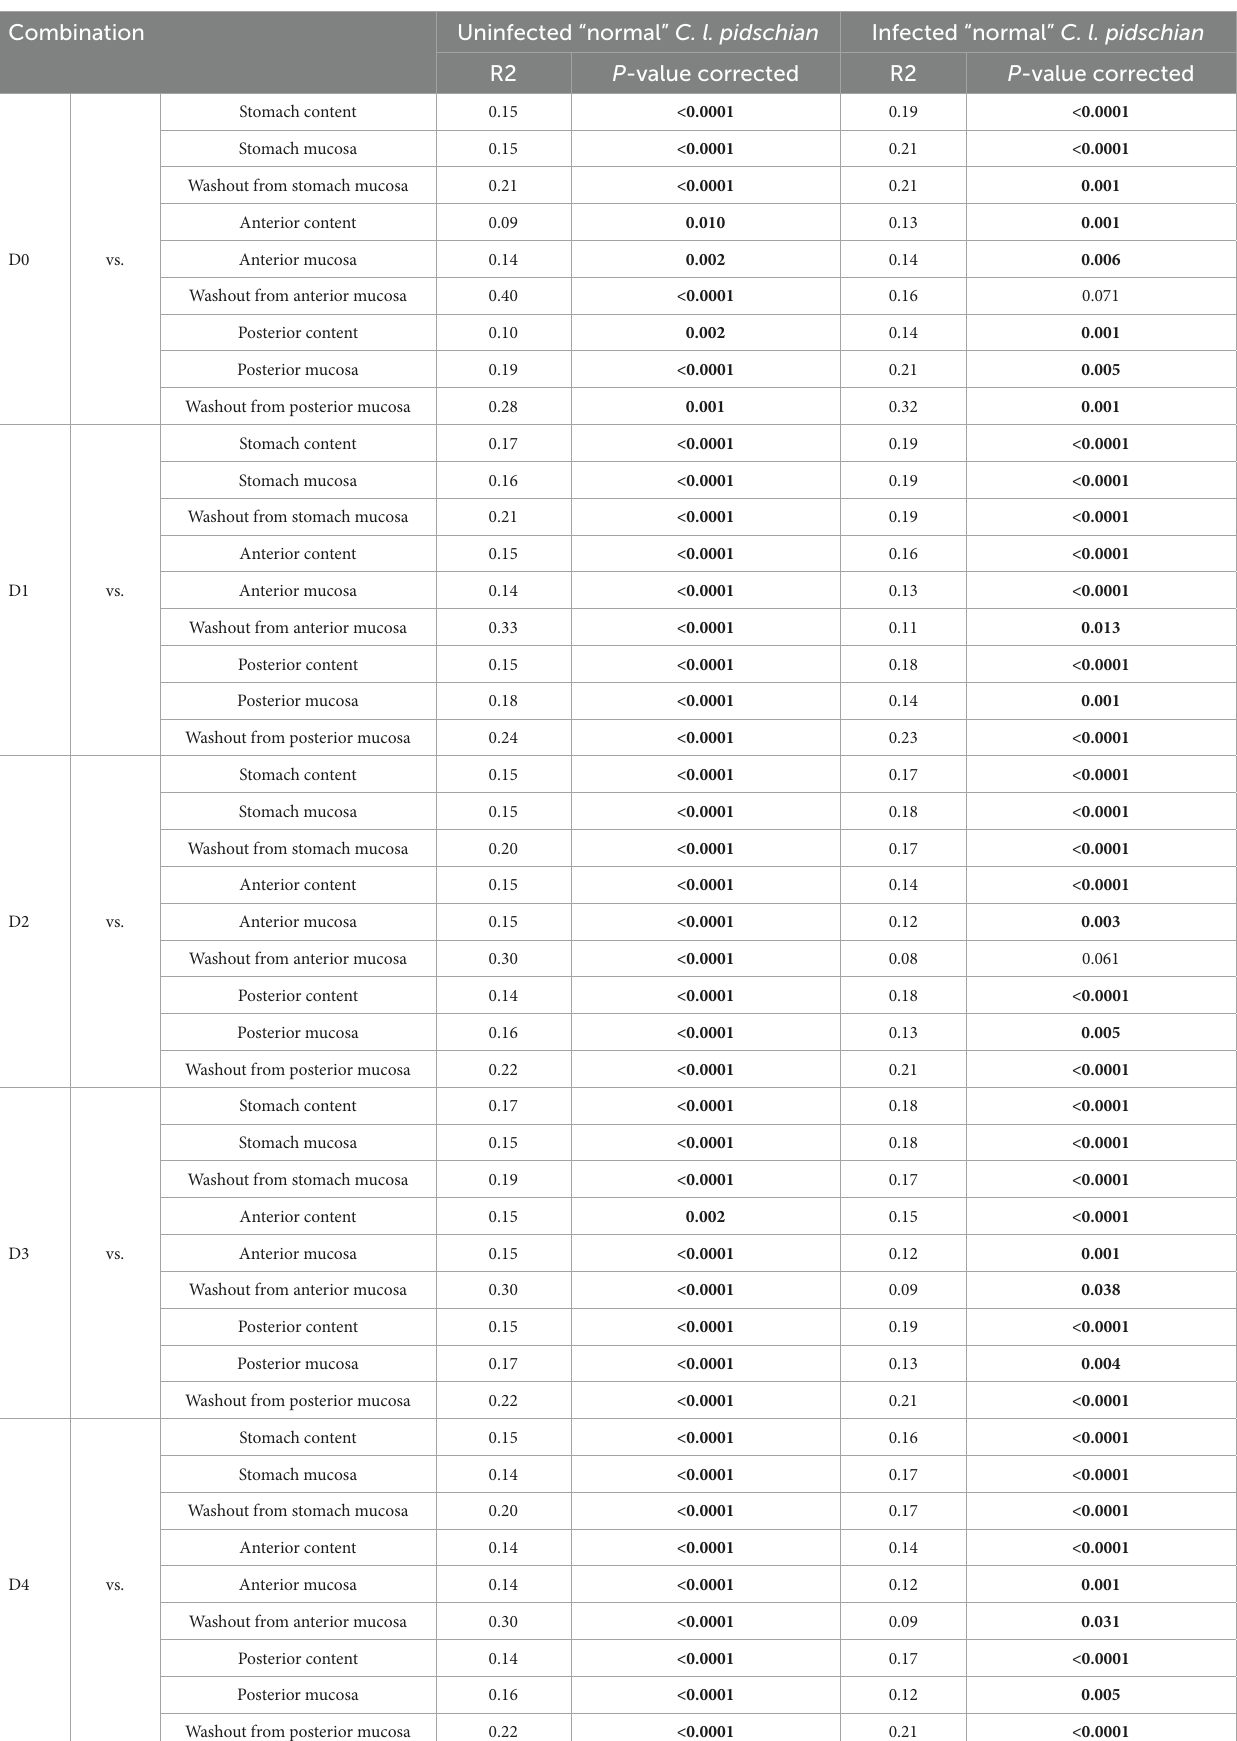
TABLE 3 Comparison of the associated microbiota between different types of samples using ADONIS test based on Bray-Curtis matrix.